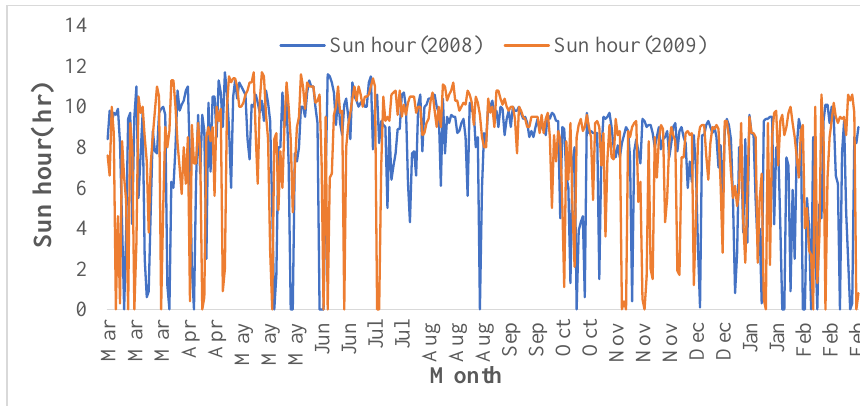
Figure 6. Evaporation time series in 2008 and 2009.